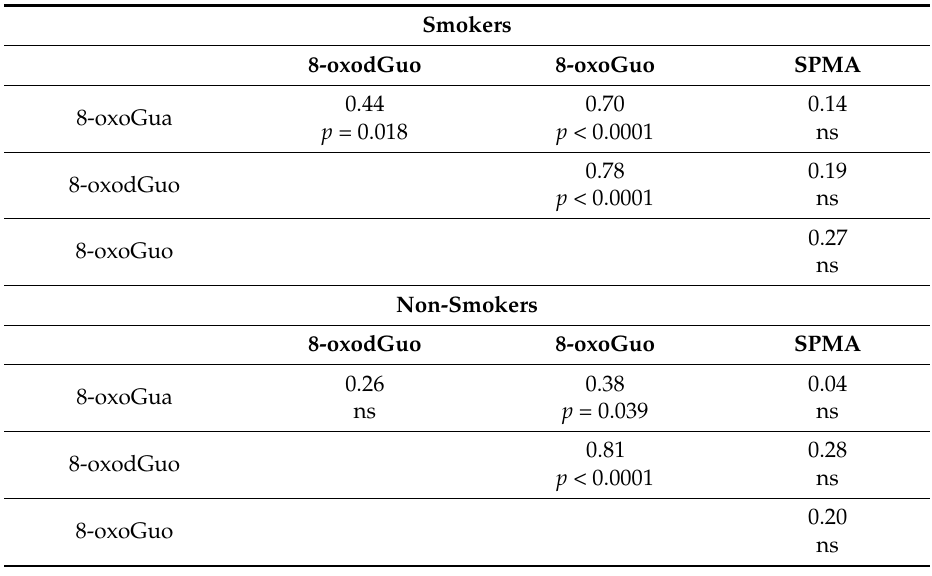
Table 5. Pearson’s log-correlations in Group 1.